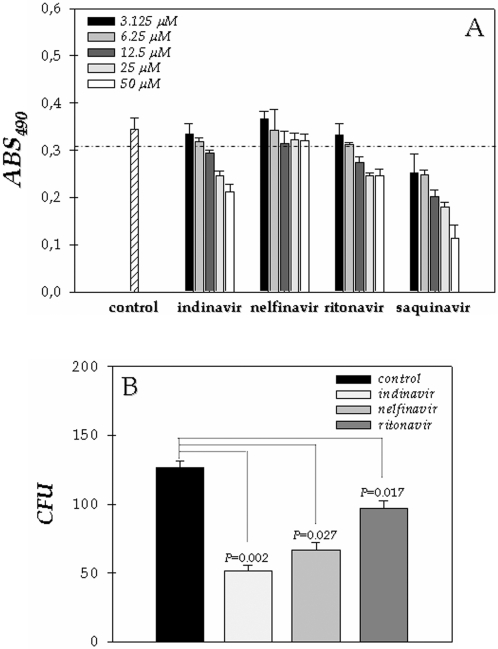
Effect of aspartyl PIs on the viability and killing activity of macrophage cells (RAW264.7 lineage).Initially, the macrophages (1×105 cells) were incubated in a 96-well plate for 24 hours in the absence or in the presence of different concentrations (3.125, 6.25, 12.5, 25 and 50 µM) of the following PIs: indinavir, saquinavir, ritonavir and nelfinavir. After this period, the viability of the macrophage cells was determined spectrophotometrically at 490 nm by means of MTT assay. The dotted line separates the graphic in two portions: minor than and equal or major than 90% of macrophage viability (A). After that, we studied the influence of aspartyl PIs on the killing activity of macrophages. In this context, we repeated the interaction of conidia with macrophage (ratio of 10∶1, respectively) for 1 hour, followed by exhaustive washing in PBS and then incubated the interaction for additional 24 hours in the absence (control) or in the presence of indinavir, nelfinavir and ritonavir at 6.25 µM, concentration in which more than 90% of the macrophage cells were viable as demonstrated in (A). Finally, the adhered macrophages were washed, lysed with sterile cold water, and the resulting suspension was plated on Czapek solid medium to count the number of CFU (B).